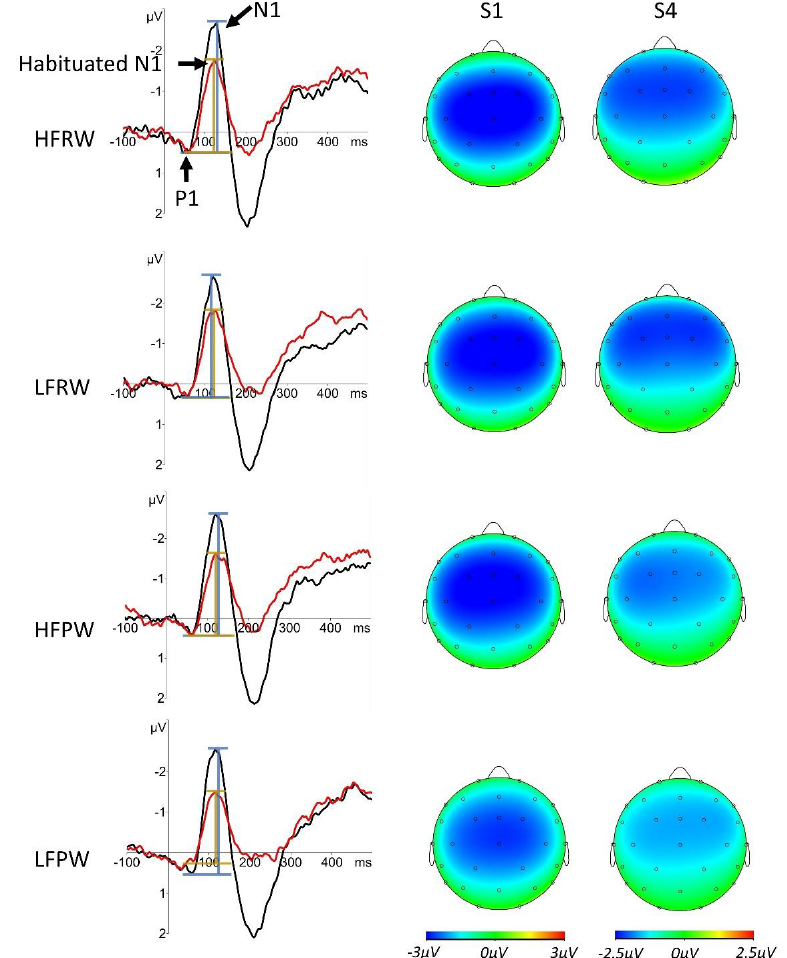
Figure 2. The grand average of the averaged AEP waveforms of C3 and C4 (left column) for the four conditions in S1 (black) and S4 (red), aligned with the topographic maps of the grand-averaged N1 according to the peak latency at C4 in S1 (middle column) and S4 (right column), in the four conditions. Differential scales were used for S1 and S4 for a demonstrative purpose. In the AEP waves, the blue bars denote the N1 peak-to-peak amplitudes (N1-P1) in S1, compared with the habituated N1, as marked by the golden bars. Note the relatively lower ratio of the length of the line segment for S4 in the length of the segment for S1 in low-frequency pseudo word-forms (LFPW) than in high-frequency pseudo word-forms (HFPW) and in low-frequency real word-forms (LFRW), respectively.